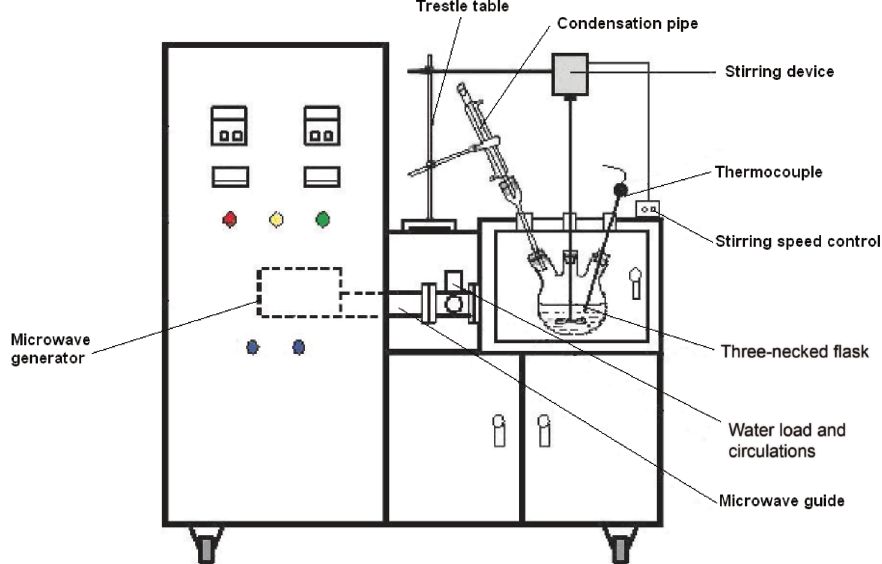
Figure 1: Diagram of the preparation of BaCO 3 powders by microwave homogeneous